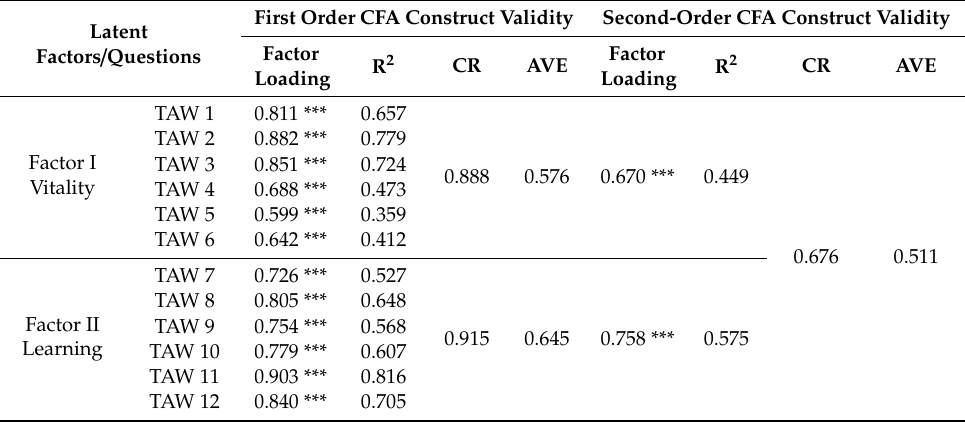
Table 3. Construct validity of first and second-order